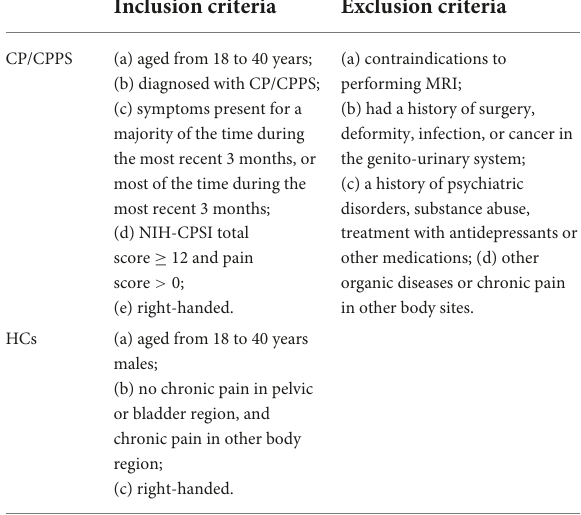
TABLE 1 Inclusion and exclusion